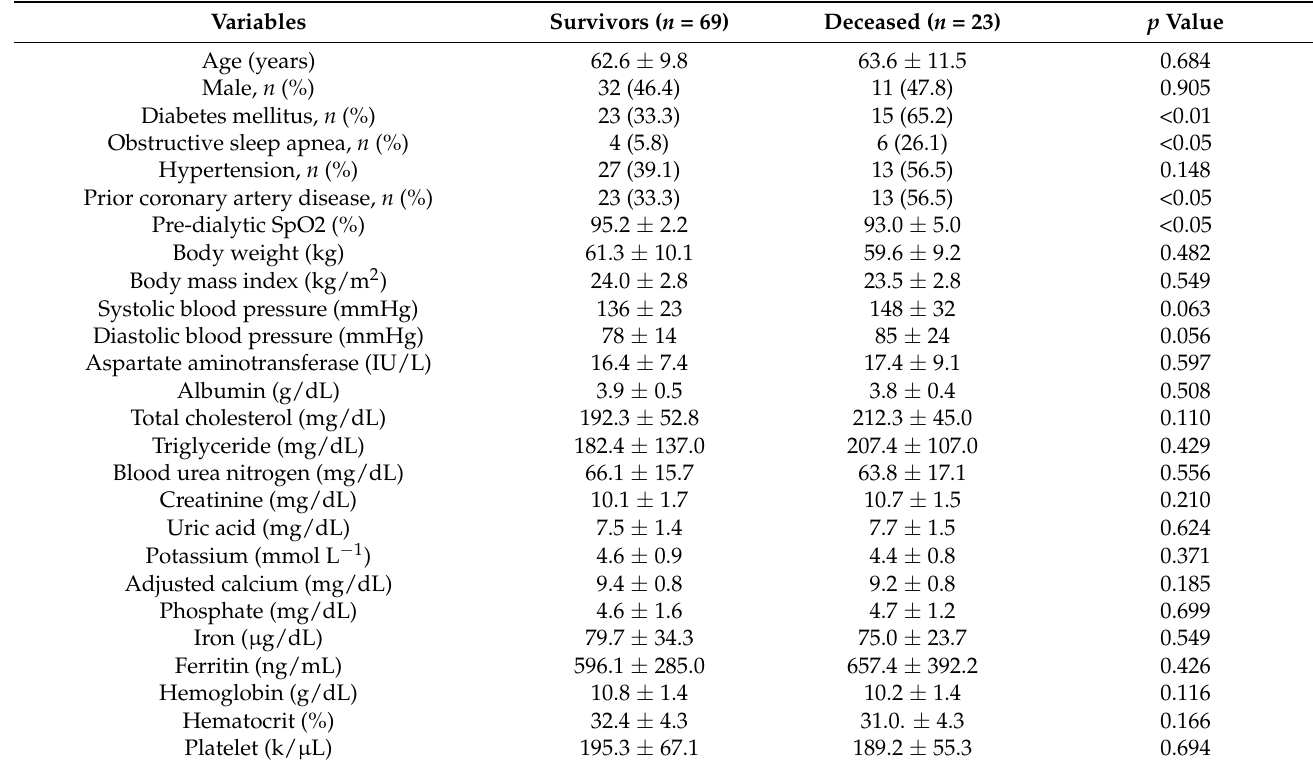
Table 2. Comparisons of bio-clinical parameters between survivors and non-survivors according to all-cause mortality.